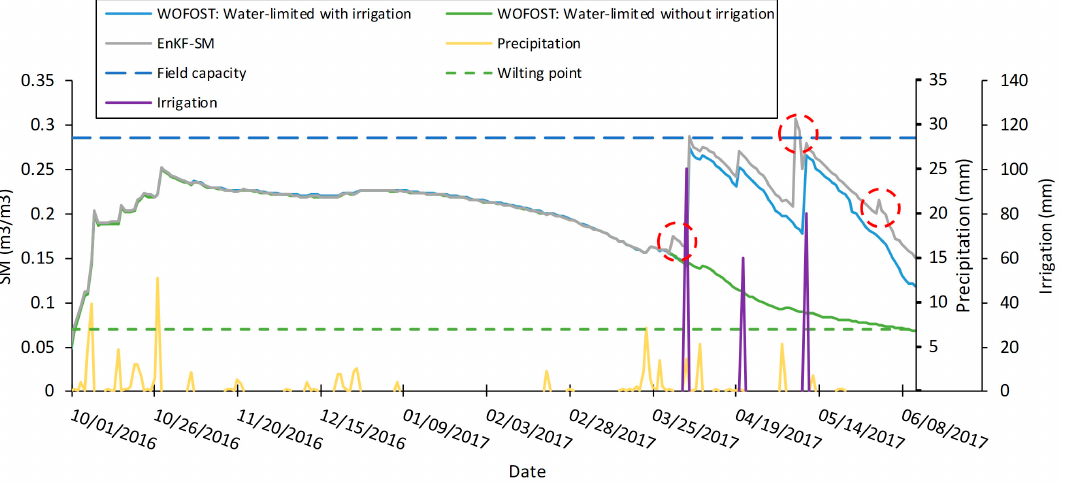
Figure 6. Comparison of the SM curves simulated by WOFOST model with and without the EnKF-based assimilation method (a sample point in Shenzhou county).